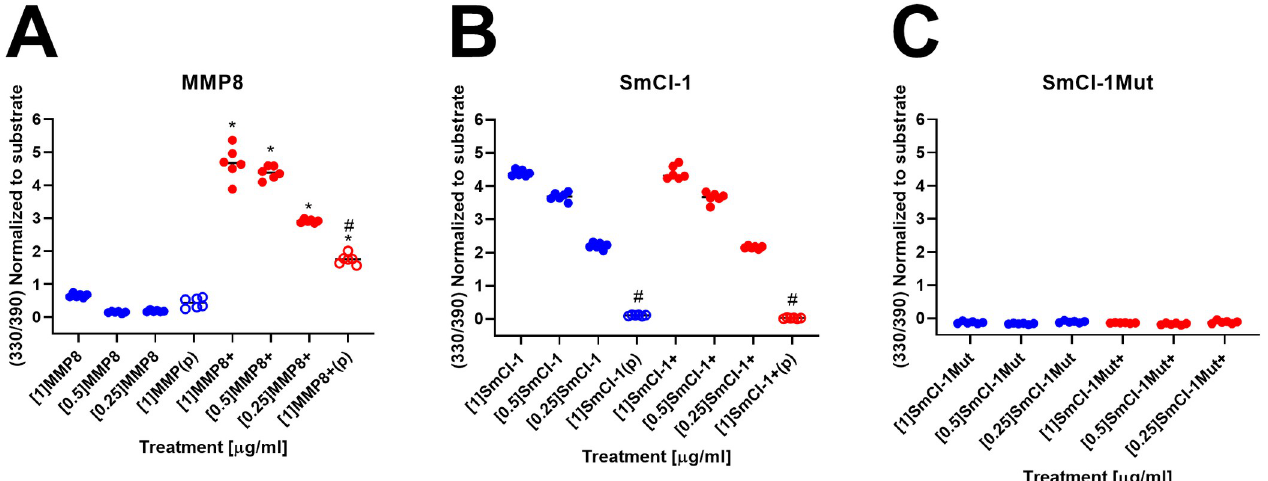
Fig 2. Recombinant SmCI-1 is a functional matrix metalloprotease. MMP activity of (A) human MMP8, (B) rSmCI-1, and (C) rSmCI-1Mut. All proteases were examined at three initial concentrations of 1 μ g/ml, 0.5 μ g/ml, and 0.25 μ g/ml. Whereas MMP8 and rSmCI-1 demonstrated activity, rSmCI-1Mut did not. Human MMP8 required activation with 1mM APMA(+), rSmCI-1 had similar activity levels with and without APMA-mediated activation. Significant inhibition via the addition of [50 μ M] (p) or [250 μ M] (P) of 1,10-phenanthroine is denoted by (#). Activated samples (+) that differ significantly from their non-activated counterparts of an identical concentration are denoted using ( � ). (n =